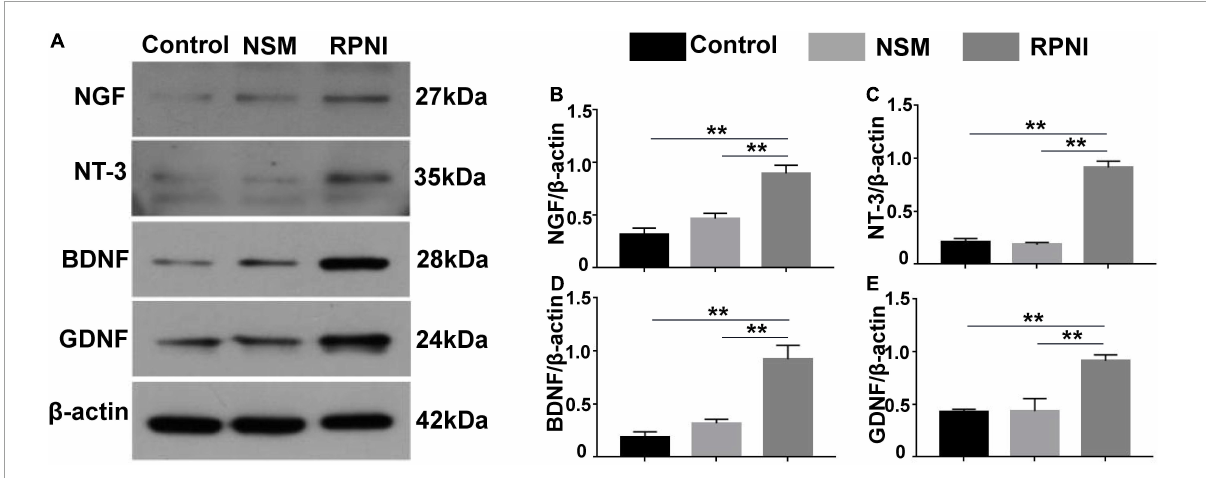
FIGURE5 Western blot results of NTs in ipsilateral DRG. (A) Western blotting bands of NGF, NT-3, BDNF, and GDNF expressions from pooled ipsilateral L4 and L5 DRGs harvested at 8 weeks after surgery. (B–E) The quantifications of corresponding western blot signals in panel (A) . (** p < 0.01). BDNF, brain-derived neurotrophic factor; DRG, dorsal root ganglia; GDNF, glial cell line-derived neurotrophic factor; NSM, nerve stump implantation inside the muscle; NGF, nerve growth factor; NT-3, neurotrophin-3; NTs, neurotrophins; RPNI, regenerative peripheral nerve